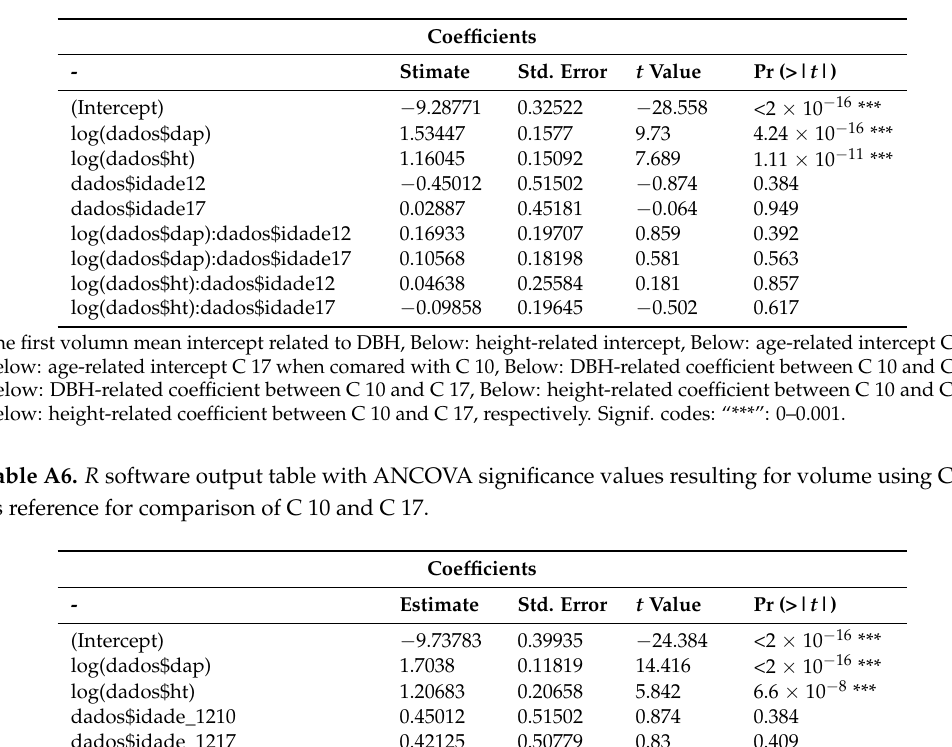
Table A5. R software output table with ANCOVA significance values resulting for volume using C 10 as reference for comparison of C 12 and C 17.